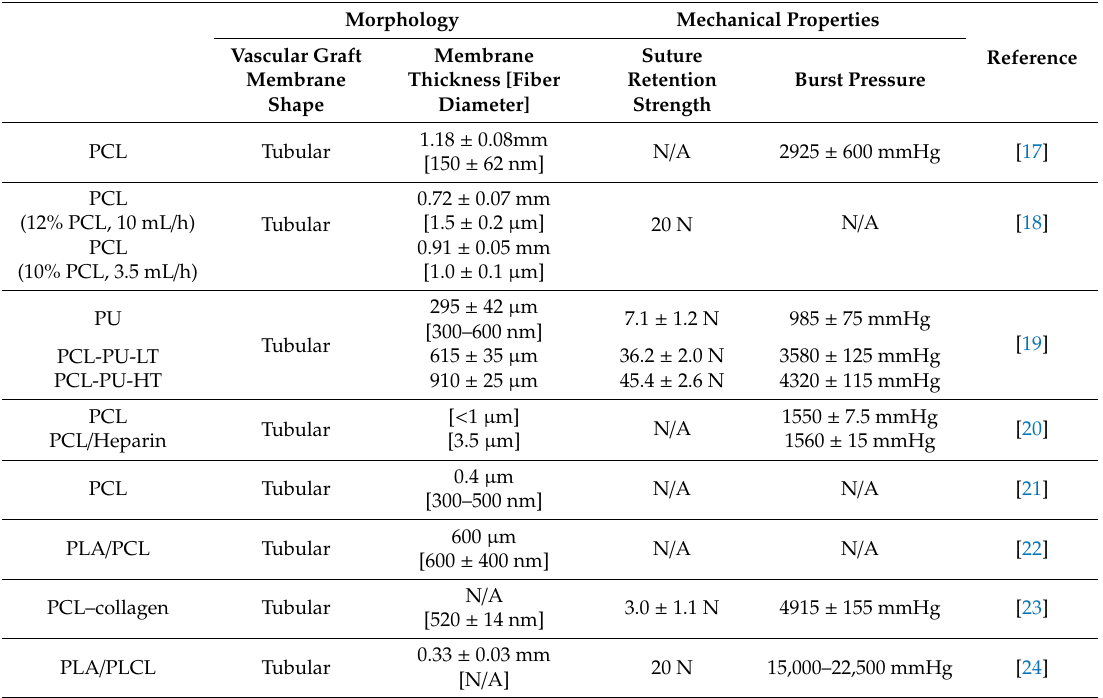
Table 1. Summary of morphology and mechanical properties of electrospun vascular grafts based on poly( ε -caprolactone) PCL and related